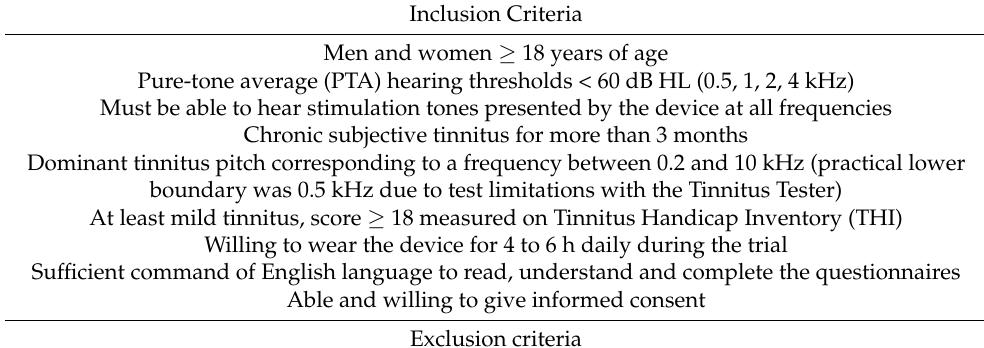
Table 1. Inclusion and exclusion criteria assessed during the telephone screening and eligibility assessment (visit